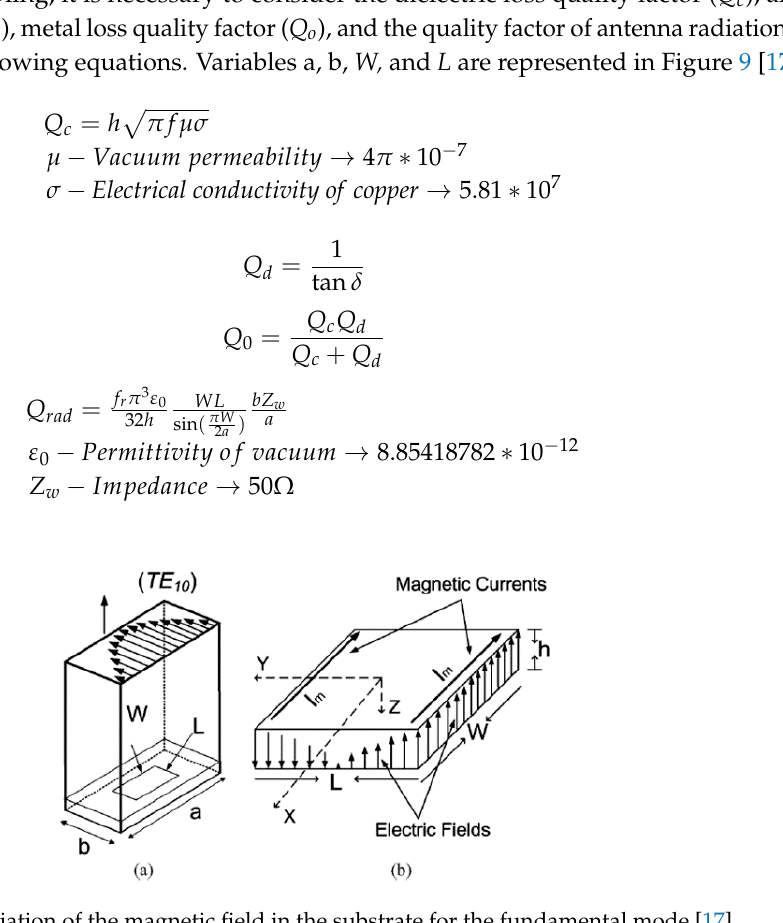
Figure 9. Variation of the magnetic field in the substrate for the fundamental mode [17].